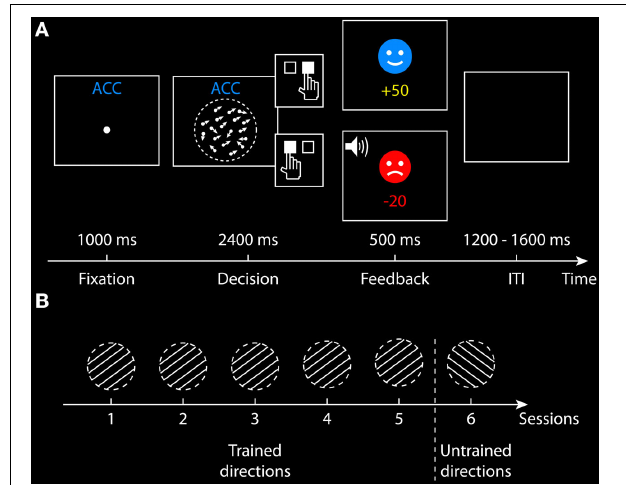
FIGURE 2 | Behavioral paradigm. (A) Structure of a single trial in the accuracy condition. A fixation point was presented for 1000ms. The random dot kinematogram was then presented for a maximum of 2400ms, during which participants made a binary decision on whether the coherent motion direction is leftward or rightward by pressing one of the two response buttons. For a correct response, a smiley face was presented for 500 and 50 points was credited. For an incorrect response, a sad face was presented and 20 points was lost, together with an auditory feedback. The payoff in the speed condition was slightly different (see section Task and Procedurefor more details). The intertrial interval (ITI) was randomized between 1200 and 1600ms. (B) Training procedure across six sessions. In the first five sessions, half of the participants trained at two directions (30 and 210 ◦ ), and the other half trained at two different directions (150 and 330 ◦ ). In the sixth session, all participants performed the task at two new directions that were not presented in their first five sessions (i.e., untrained